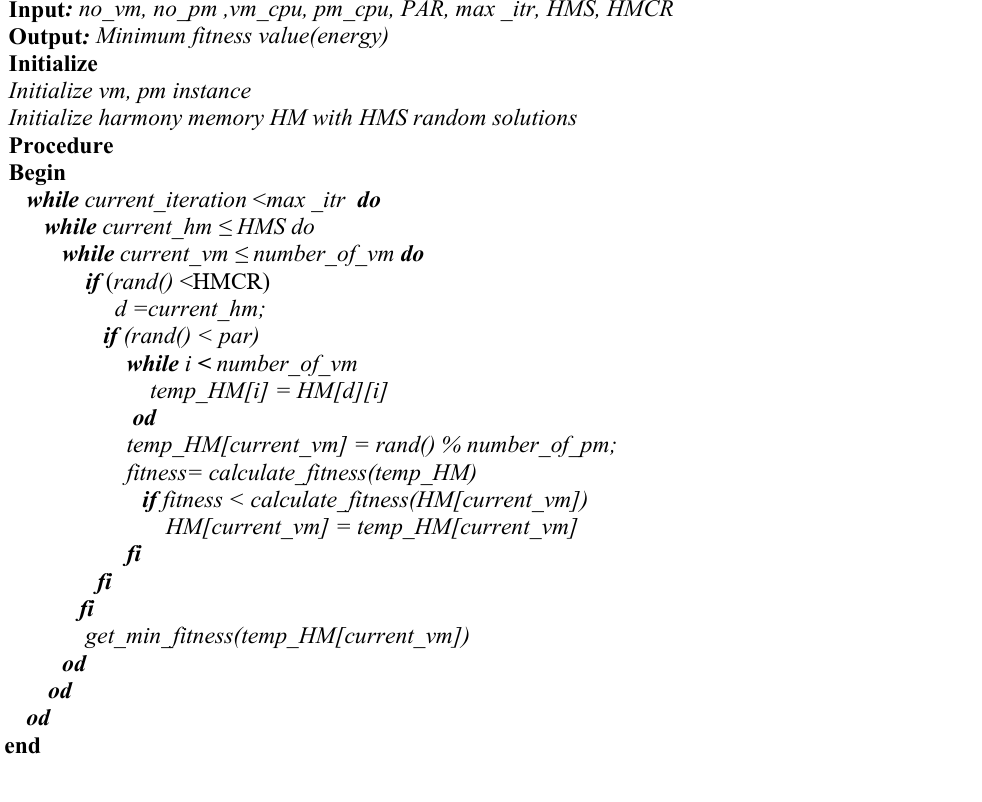
Algorithm 1 : Pseudocode for the HSA with static